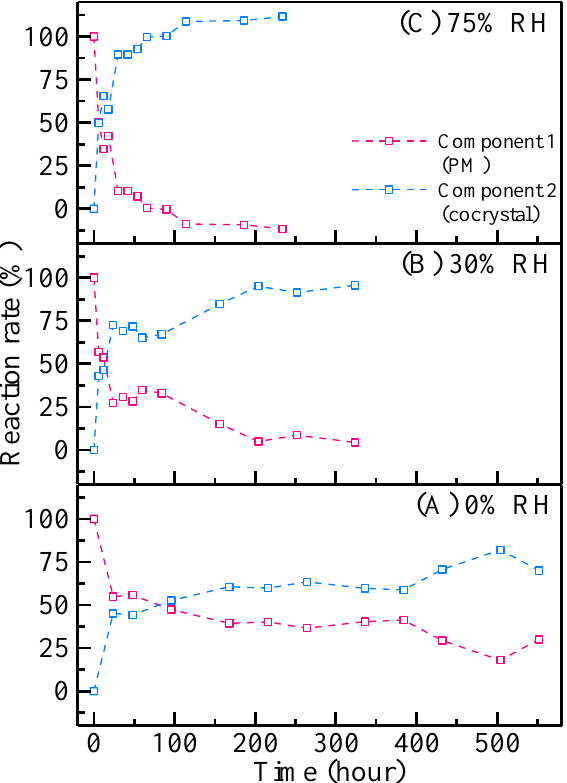
Figure 5. Reaction rate in the 3275–3360 cm –1 region of the FT-IR spectrum. Red and blue lines represent the PM (component 1) and cocrystal (component 2), respectively. ( A – C ) are results obtained under 0%, 30% and 75% RH, respectively.